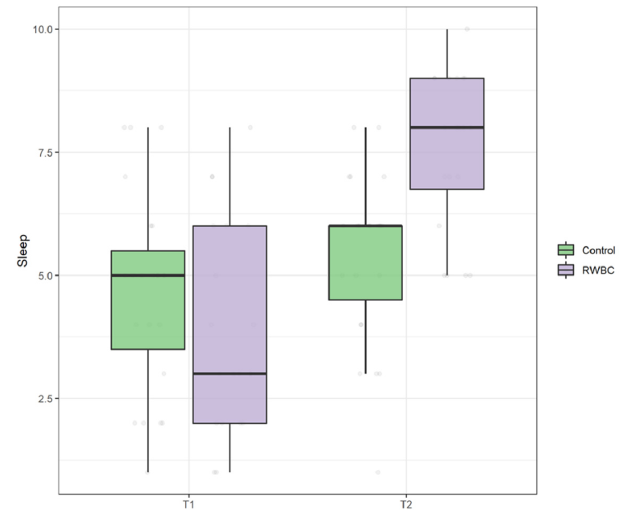
Figure 6. Boxplot of sleep quality scores at T0 and T1 in control group and intervention group (RWBC).